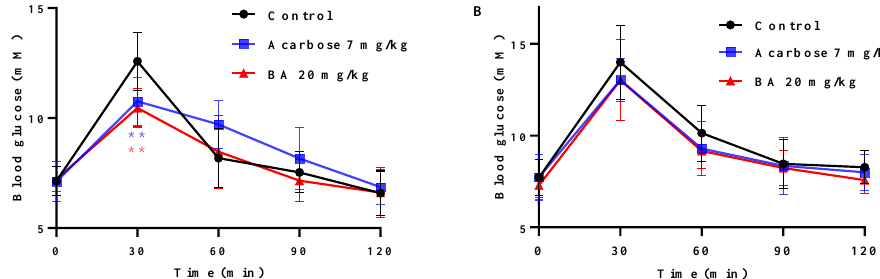
Figure 5. Effects of BA and acarbose on postprandial blood glucose levels in normal mice ( n = 8). ( A ) Blood glucose after oral administration tests of mixed maltose and sucrose (each 1.0 g/kg); ( B ) Blood glucose after oral administration tests of glucose (2.0 g/kg). Data are expressed as means ± SD; ** p < 0.01 indicates a significant difference compared to control by t -test.